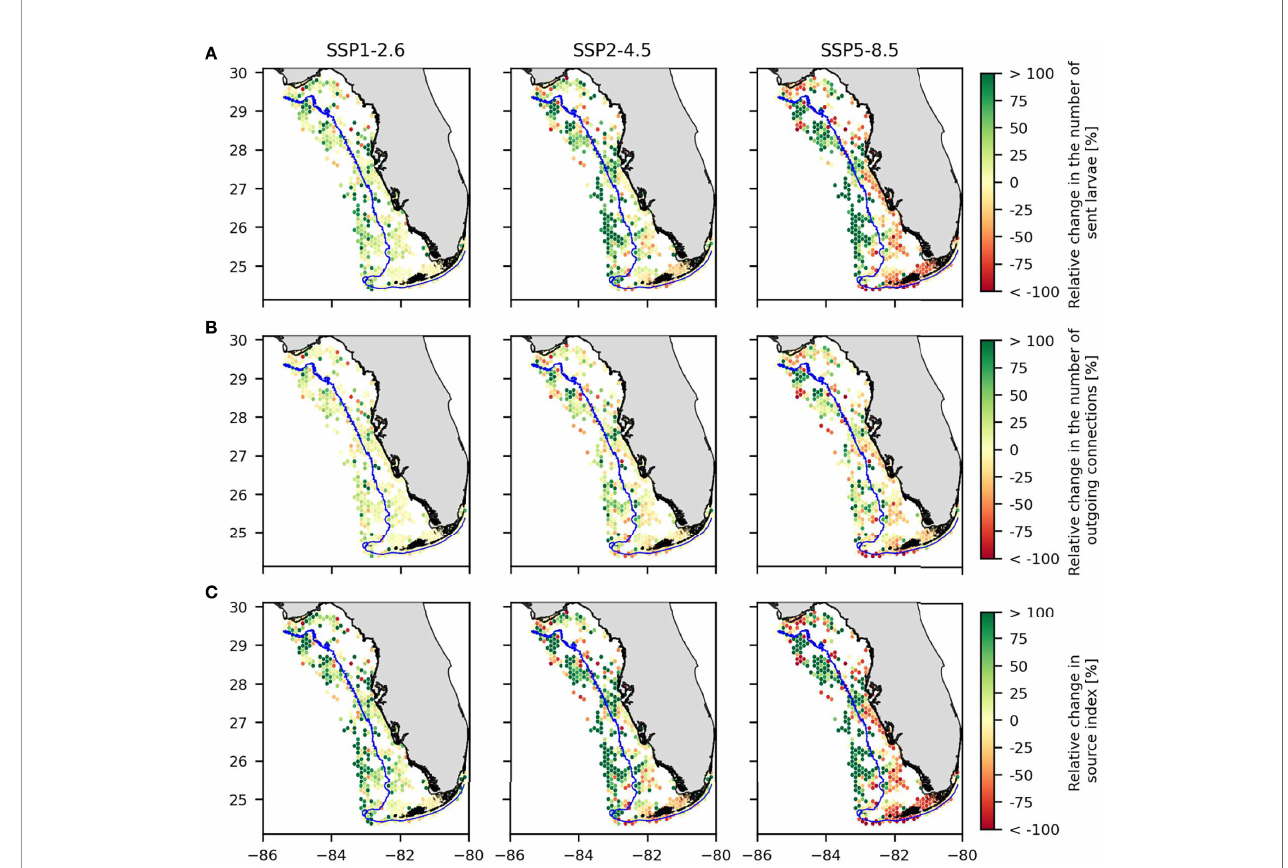
FIGURE 5 | Relative change in (A) the number of larvae sent away that settle, (B) the number of outgoing connections with sink habitats and (C) the source index for the three climate change scenarios compared to present-day values. The blue line represents the limit between the fi shing and non- fi shing